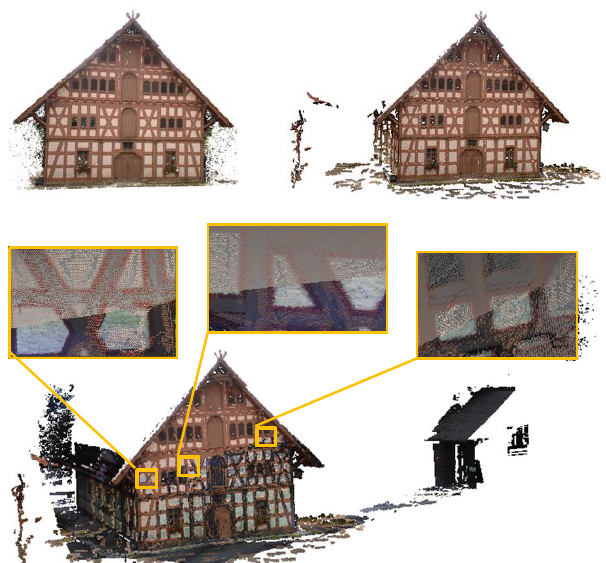
Figure 7. Dense image point cloud generated by PMVS combined together with the old farm‘s laser point cloud (bottom), dense image point cloud generated by the SGM using SaM outputs, about 5 million pts (upper left) and dense image point cloud generated by the PMVS using OI outputs, about 0.5 million pts (upper